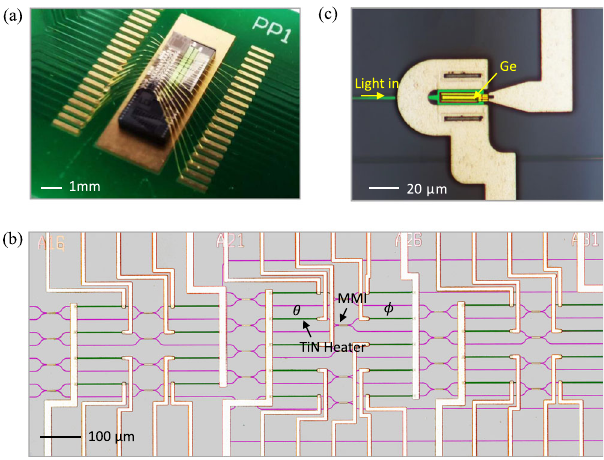
Fig. 2 Fabrication and packaging of silicon photonic chip. a Chip packaging. b A false-colour micrograph of the the MZI network with integrated heaters. c A false-colour micrograph of an on-chip photodetector.